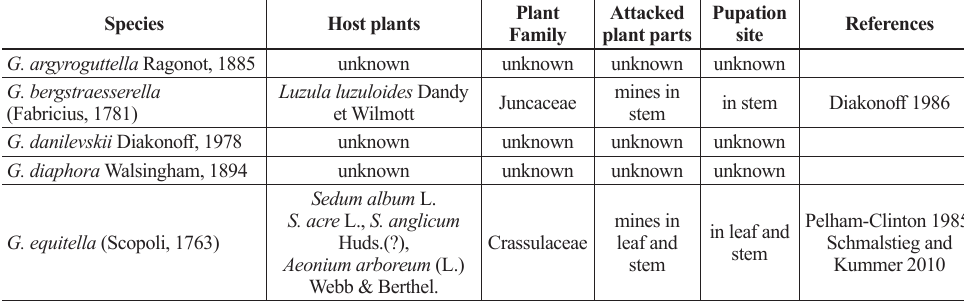
Table 1. Host plants of the European Glyphipterix